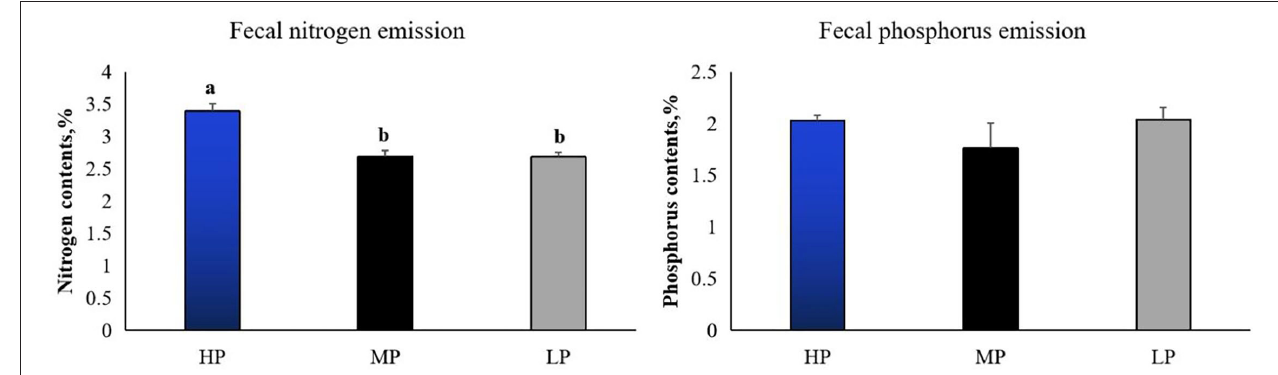
FIGURE 1 | Effect of low-protein diet on the fecal nitrogen and phosphorus emissions in finishing pigs. HP, high protein (16% crude protein); MP, medium protein (12% crude protein); LP, low protein (10% crude protein). a − b Column with different numbers indicate that there is a significant difference among different treatments ( P < 0.05).